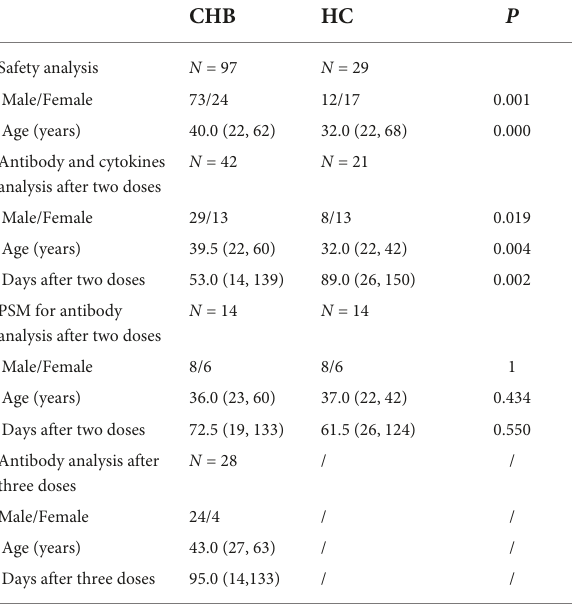
TABLE 1 Characteristics of subjects enrolled in this study.